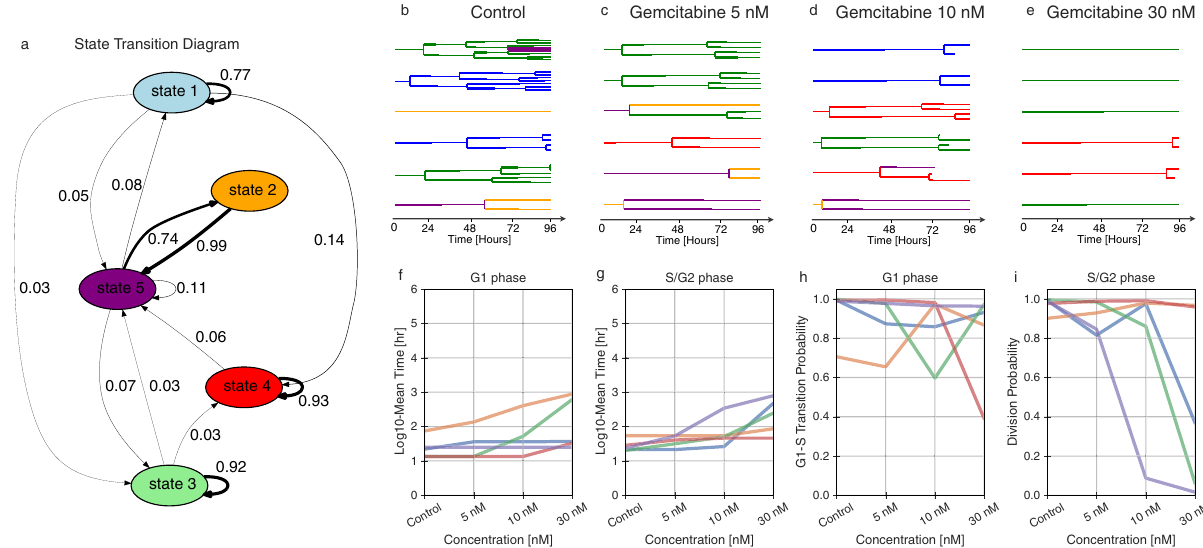
Fig. 9 State-speci fi c inferences of the gemcitabine-treated data. a State transition graph showing the probability of state transitions among the predicted states. The transitions with less than a 0.03 probability have been removed. b – e A sample of lineage trees after fi tting the model and state assignment (control, 5 nM, 10 nM, and 30 nM). f , g The log 10 fi t mean time of G1 and S/G2 phase durations for different concentrations. h , i The Bernoulli parameter, indicating the probability of G1-to-S phase transition versus cell death ( h ), and the probability of division versus cell death ( i ) for each higher rates of cell death overall (Supplementary Fig. 14a/g). In total, the tHMM model was effective in identifying subsets of cells with divergent phenotypic responses to drug treatment alongside the relationships between cells in the population.